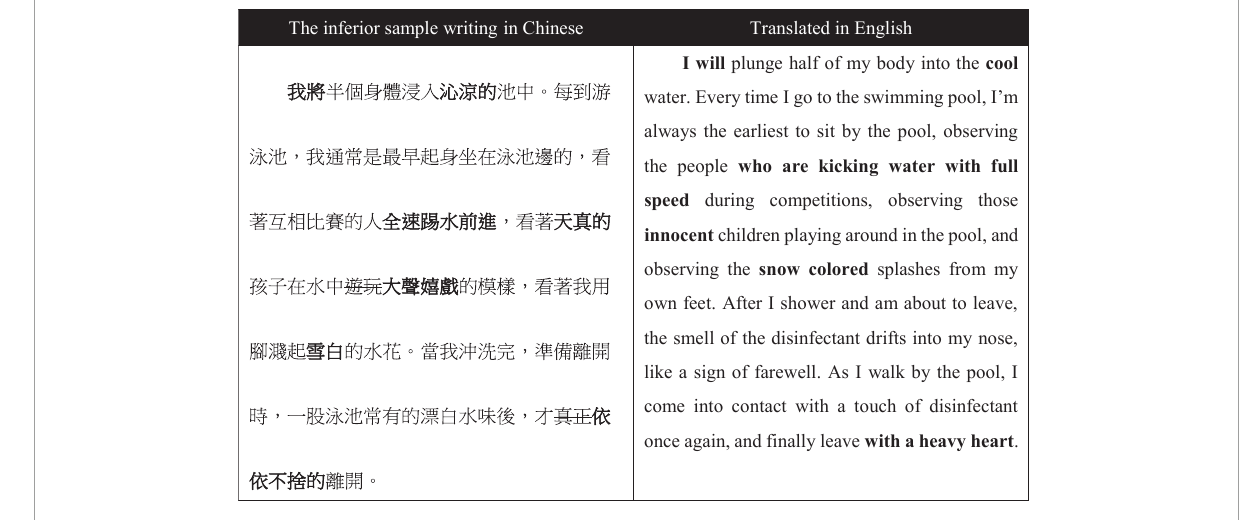
FIGURE2 Example of a student’s critique in the downward comparison group.